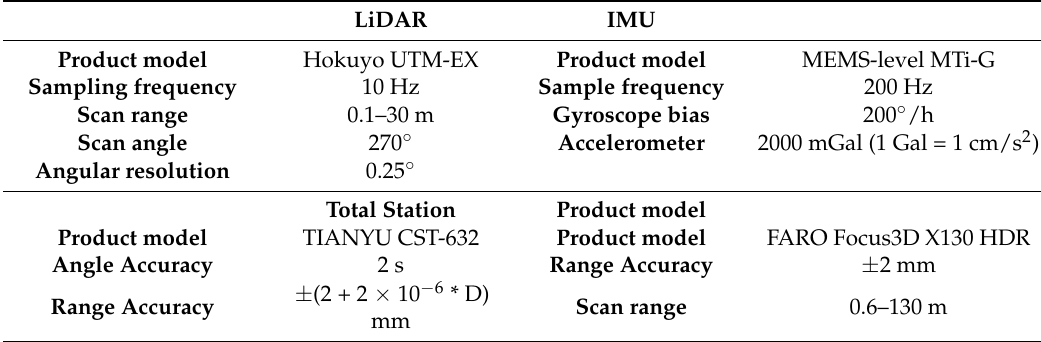
Table 1. The detailed parameters of hardware.